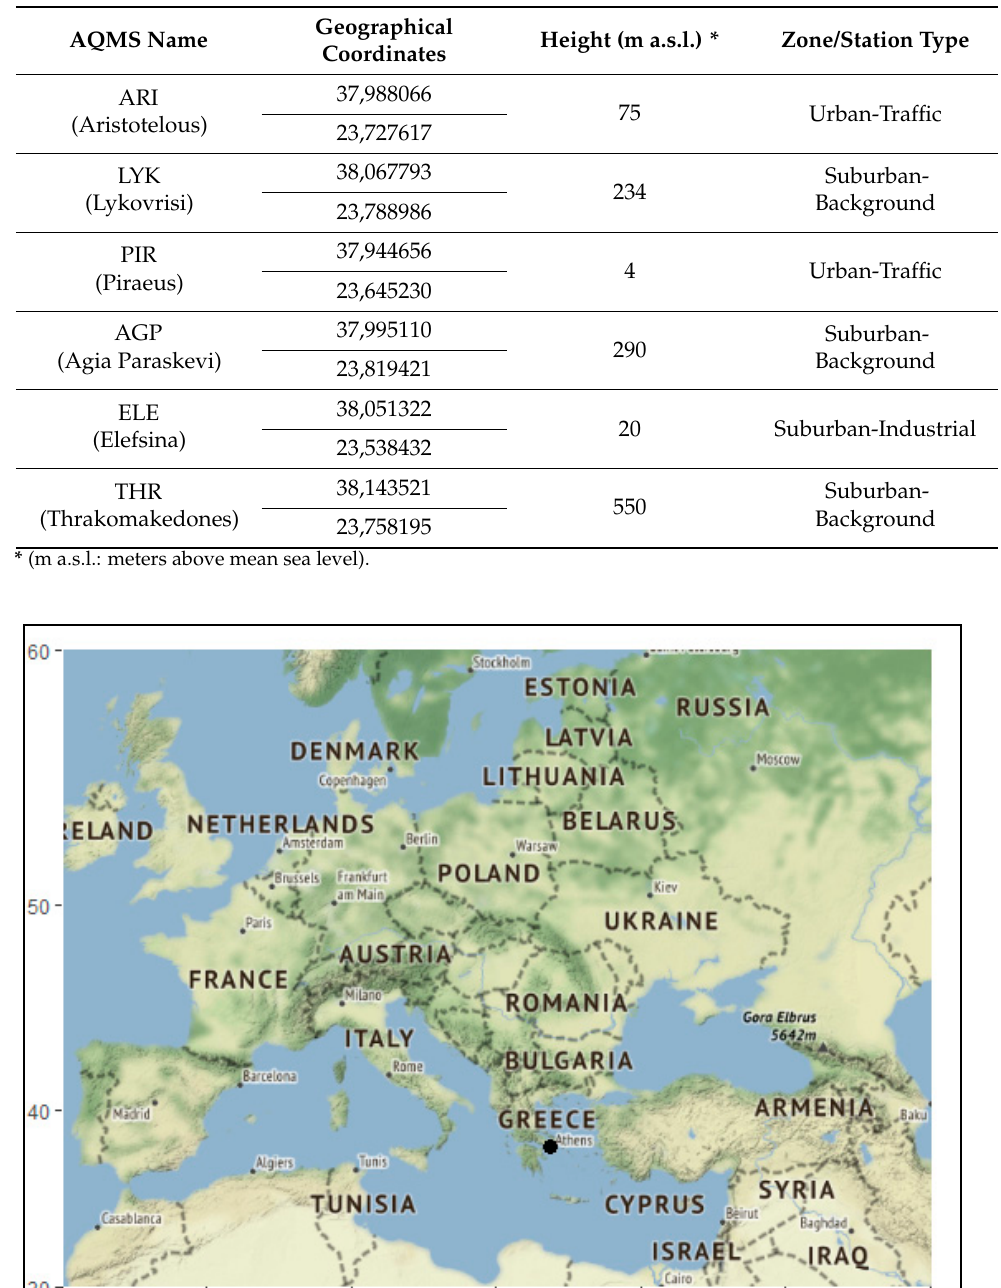
Table 1. List of the air quality monitoring stations (AQMS) along with their geographical coordinates.